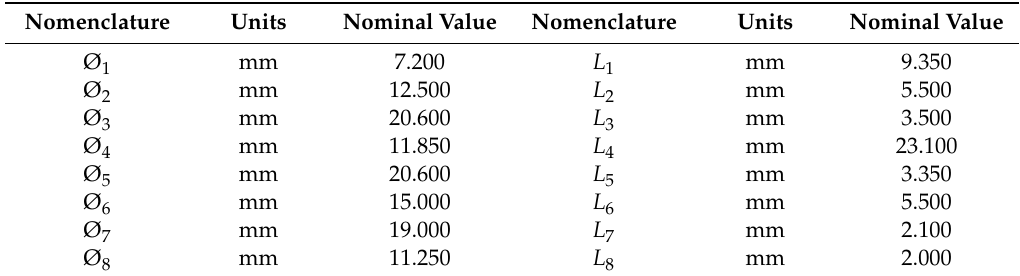
Table 2. Geometrical variables for the 3D printed end part.